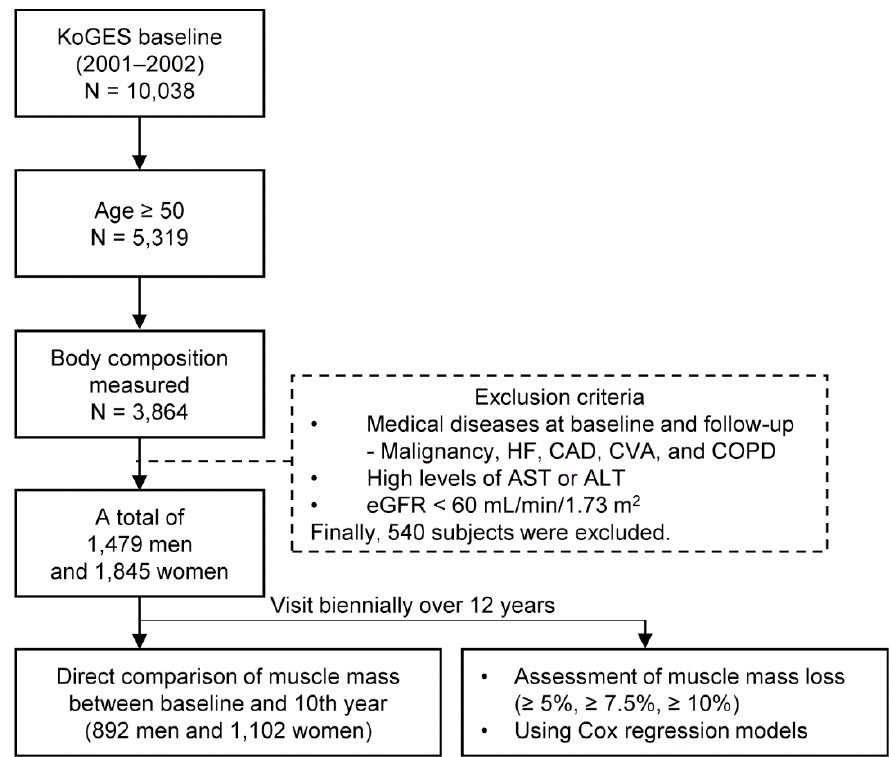
Figure 1. Flowchart of the study. KoGES, the Korean Genome and Epidemiology Study; HF, heart failure; CAD, coronary artery disease; CVA, cerebrovascular accident; COPD, chronic obstructive pulmonary disease; AST, Aspartate aminotransferase; ALT, Alanine aminotransferase; and eGFR, estimated glomerular filtration rate.